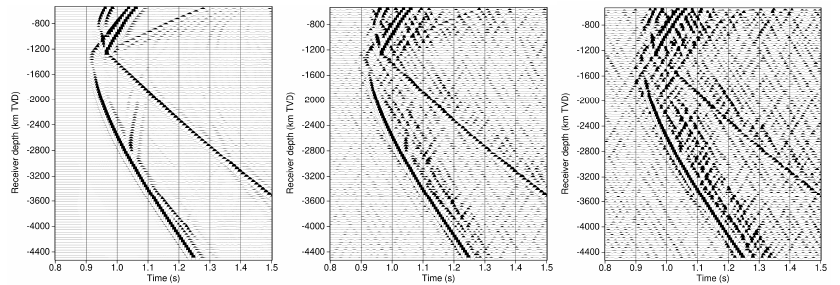
Table 4. The two noise parameters, ambient and coda, used in the noise study. The reference experiment is experiment 5 (Table 1).